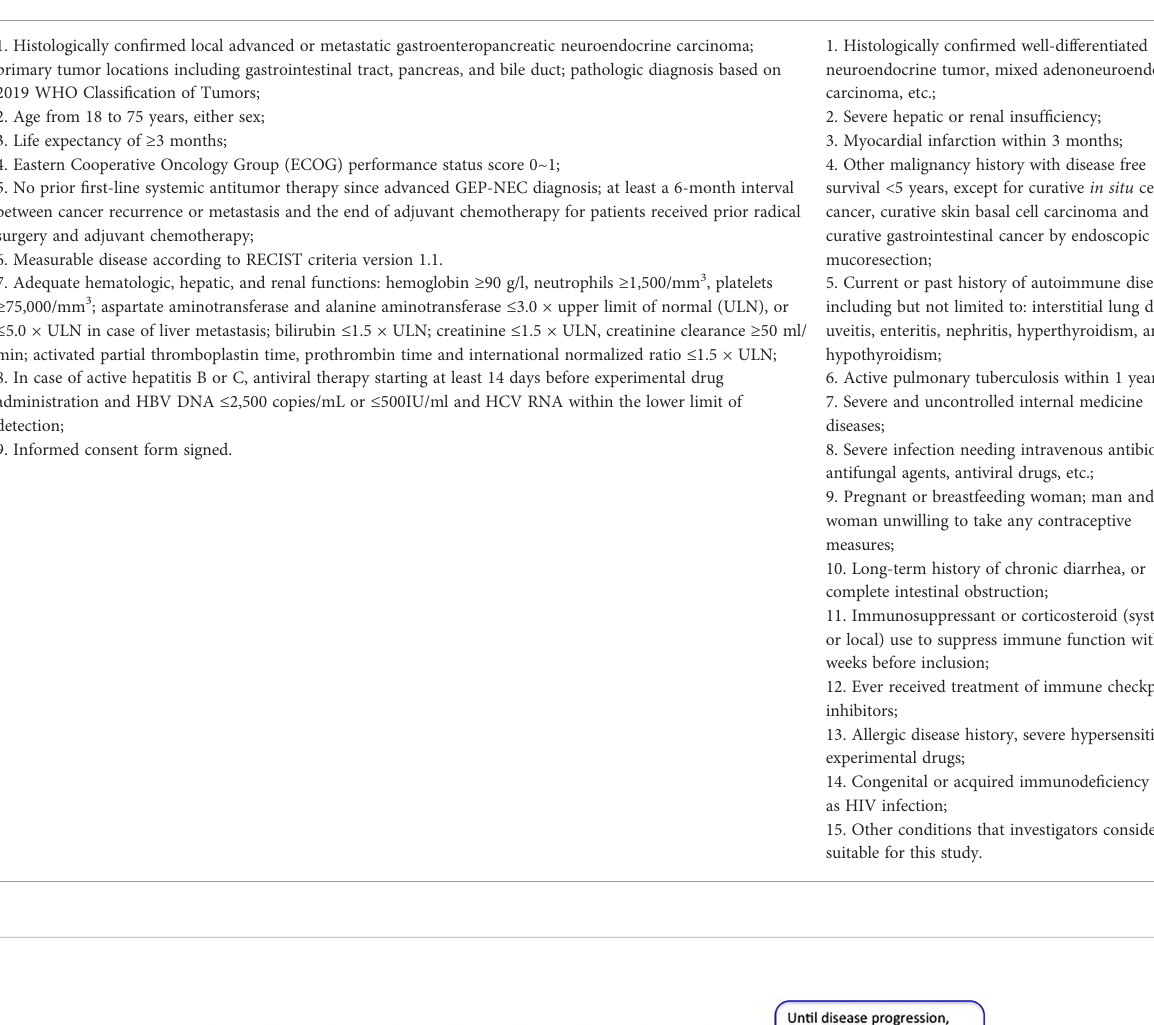
TABLE 1 Patient inclusion and exclusion criteria.